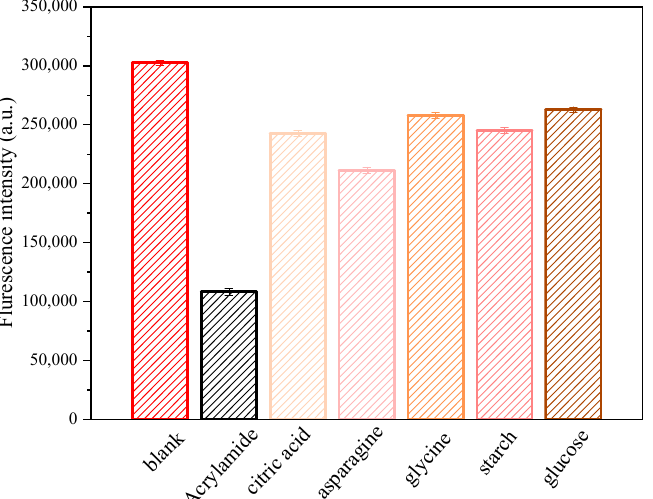
Figure 5. Effect of different substances on the fluorescence intensity of CMC/Eu (III) fluorescent probe at 615 nm.